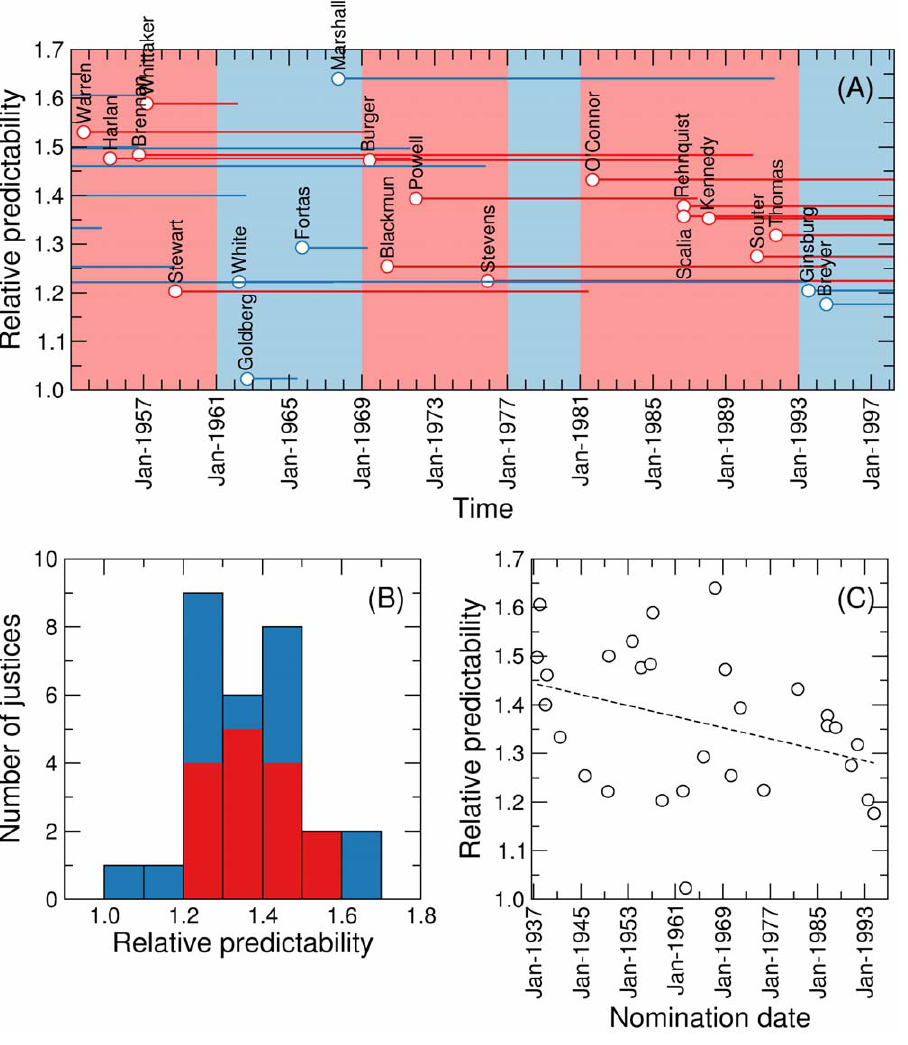
Figure 3. Relative predictability of individual U.S. Supreme Court justices. (A) Each line indicates the average relative predictability (that is, predictability according to the block model algorithm in the real court over the predictability in an equivalent ideal court) of a justice over their tenure, which is indicated by the length of the line. Red lines correspond to Republican–nominated justices and blue lines to Democrat–nominated justices. The background color indicates the party of the president. (B) Histogram of relative predictabilities. Bar colors indicate the fraction of Republican–nominated (red) and Democrat–nominated (blue) justices within each bin. (C) Relative predictability as a function of the nomination date of the judge. Relative predictability has significantly decreased during the period considered (p=0.026, Spearman’s rank correlation), as indicated by the dashed line (which is only shown as a guide to the eye).